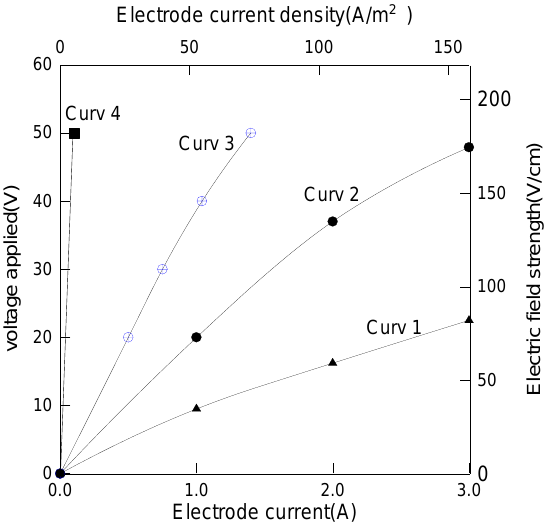
Figure 3. Dependence of the electrode current on the voltage